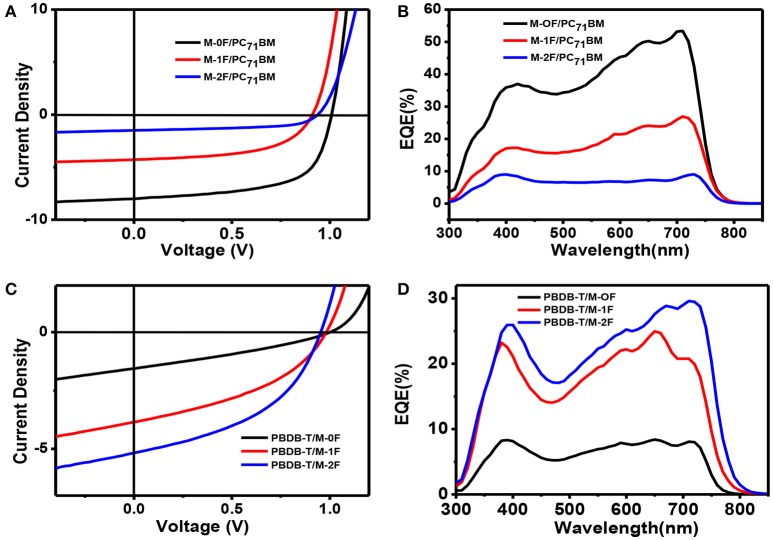
(A,B) J–V curves and EQE curves of M-0F, M-1F, M-2F With PC71BM blends at the best performance condition. (C,D) J–V curves and EQE curves of M-0F, M-1F, M-2F with PBDB-T blends at the best performance condition.